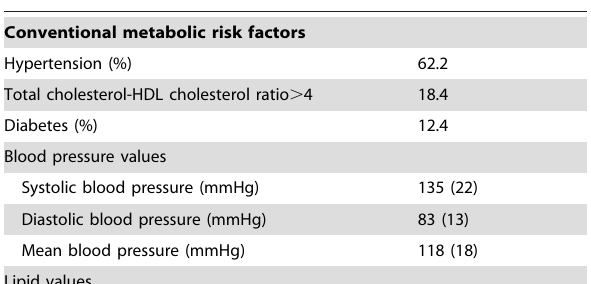
Table 1. Conventional metabolic risk factors, adipokines, endothelial activation and carotid atherosclerosis in activation and carotid atherosclerosis in 217 RA patients.